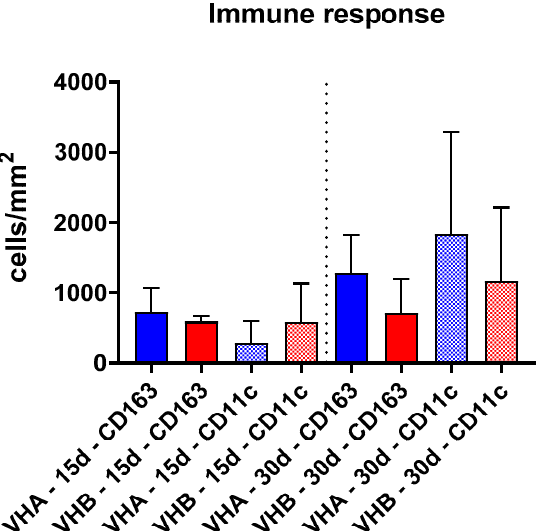
Figure 4. Results of the histomorphometrical analysis of the M1 and M2 macrophages within the implantation sites of both hydrogels (colored bars = anti-inflammatory cells, riffled bars = pro-inflammatory cells).